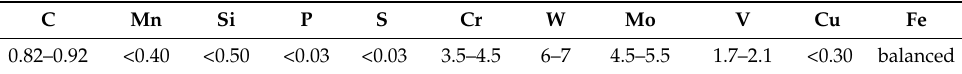
Table 1. The chemical composition of HS6-5-2 steel.